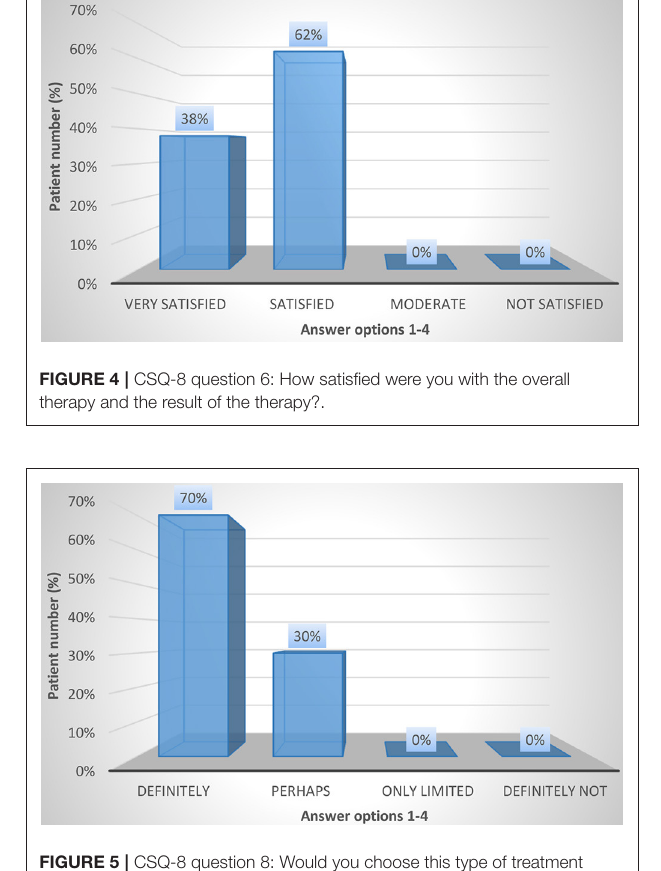
FIGURE 5 | CSQ-8 question 8: Would you choose this type of treatment